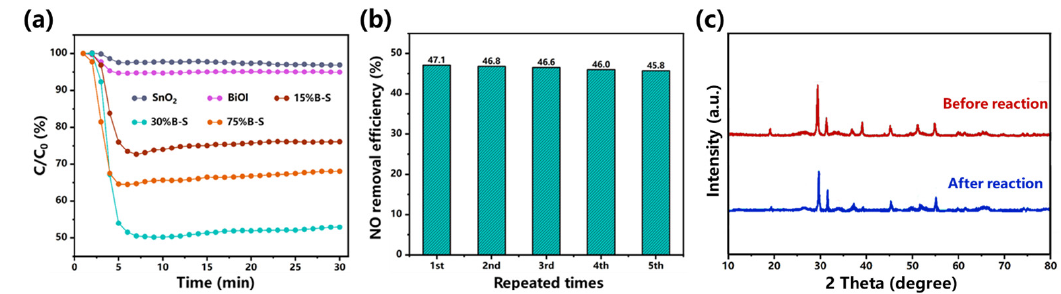
Figure 2. ( a ) Photocatalytic activity of as-synthesized catalysts for NO removal, ( b ) stability test of 30%B-S, and ( c ) XRD patterns of 30%B-S before and after cyclic test. Table 1. NO removal performance of reported p-n heterojunction photocatalysts.